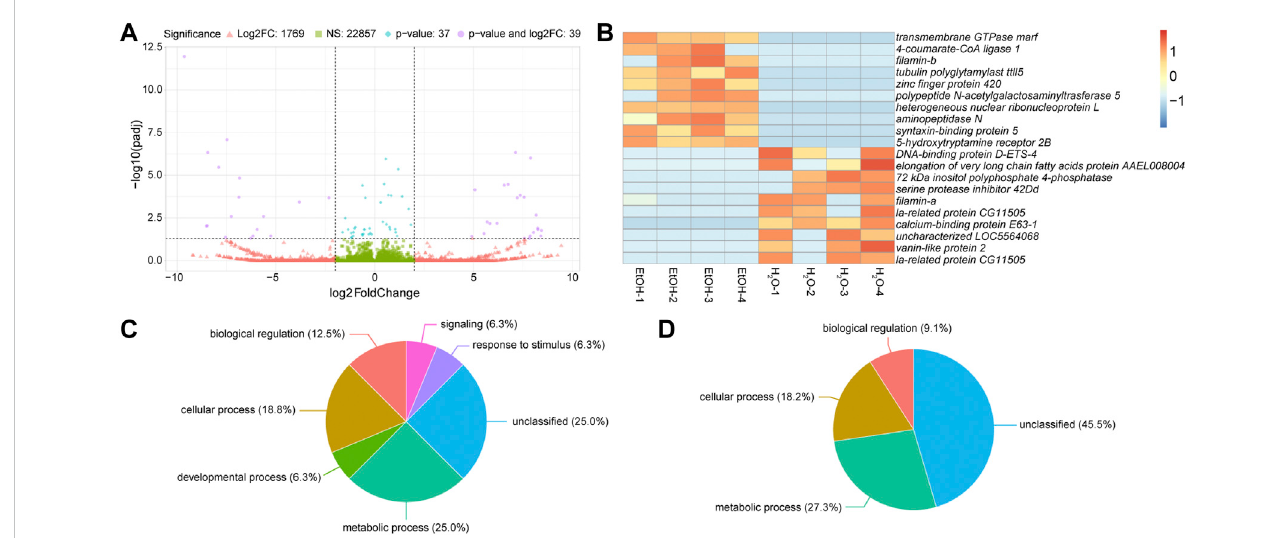
FIGURE 2 Differential gene expression between ethanol (EtOH) and water-fed non-irradiated mosquitoes. (A) . Volcano plot illustrating the differential expression patterns between transcripts with elevated expression in EtOH-fed mosquitoes (negative values) and elevated expression in water-fed mosquitoes (positive values). Vertical dashed lines represent four-fold change in expression, meaning any values more extreme than those lines are at least four-fold different between the two treatments. The horizontal dashed line represents a p -value of 0.05, so any points above this line represent genes with signi fi cantly different expression ( p ≤ 0.05) between the two treatments. Green squares represent mean expression of transcripts less than four-fold different and not signi fi cantlydifferentbetweentreatments;redtrianglesrepresentmeanexpressionoftranscriptsgreaterthanfour-folddifferentbutnotsigni fi cantlydifferent between treatments; blue diamonds represent mean expression of transcripts less than four-fold different but still signi fi cantly different between treatments; purple circles represent mean expression of transcripts that are both four-fold different and signi fi cantly differentially expressed between treatments. (B) . Heatmaps showing the ten most signi fi cantly differentially expressed transcripts with at least four-fold increase in ethanol-fed mosquitoes or water-fed mosquitoes.Eachcolumnrepresentsasinglebiologicalreplicate,andeachrowrepresentsanindividualtranscript. (CandD) .Piechartsofgeneontology(GO) analyses of genes upregulated in water-fed mosquitoes relative to ethanol-fed mosquitoes (C) and upregulated in ethanol-fed mosquitoes relative to water- fed mosquitoes (D) . Gene IDs were converted to Uniprot IDs, and all converted Uniprot IDs were used for GO analysis. Parent GO terms are represented in these charts, and the percentages represent the percent of the analyzed genes that were grouped into the corresponding